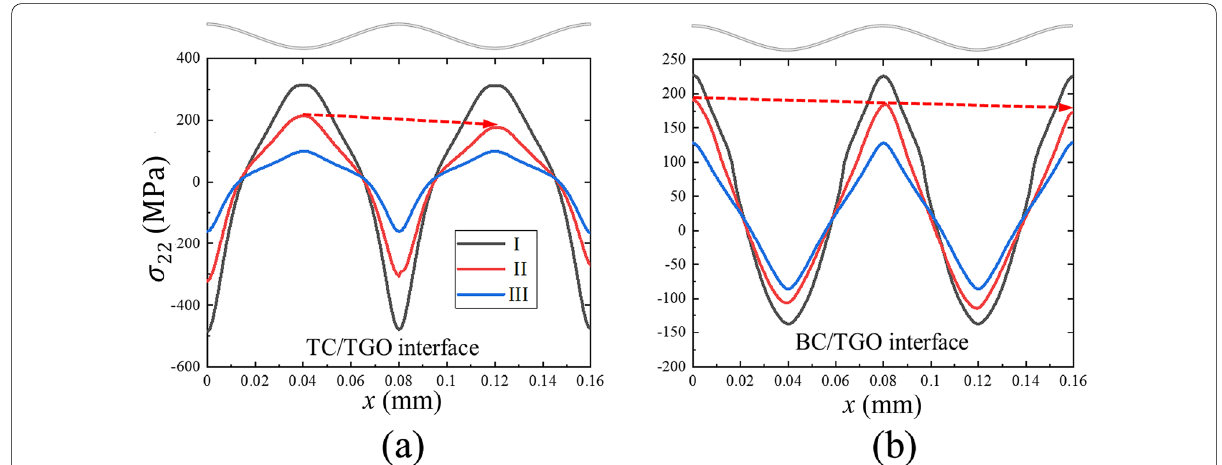
Figure 9 Distribution of σ 22 at ( a ) TC/TGO, and ( b ) BC/TGO of three critical